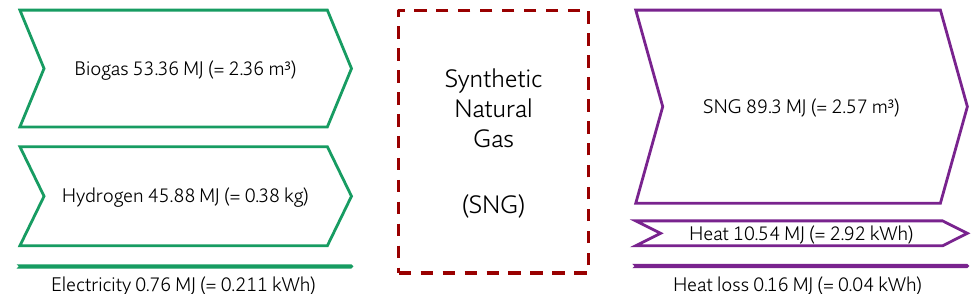
Figure 9. Energy balance for the methanization process via the hydrogenation of biogas. The illustration is based on data from the Danish Energy Agency and Energinet